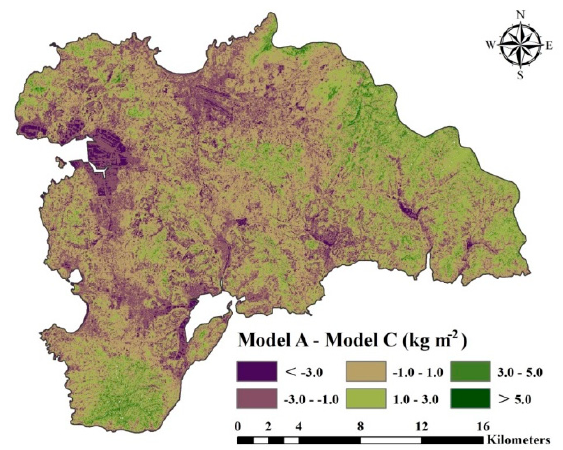
Figure 4. Difference map of soil organic carbon stocks (kg m − 2 ) derived from full variable model (Model A) and only multispectral remote sensing variables (Model C).